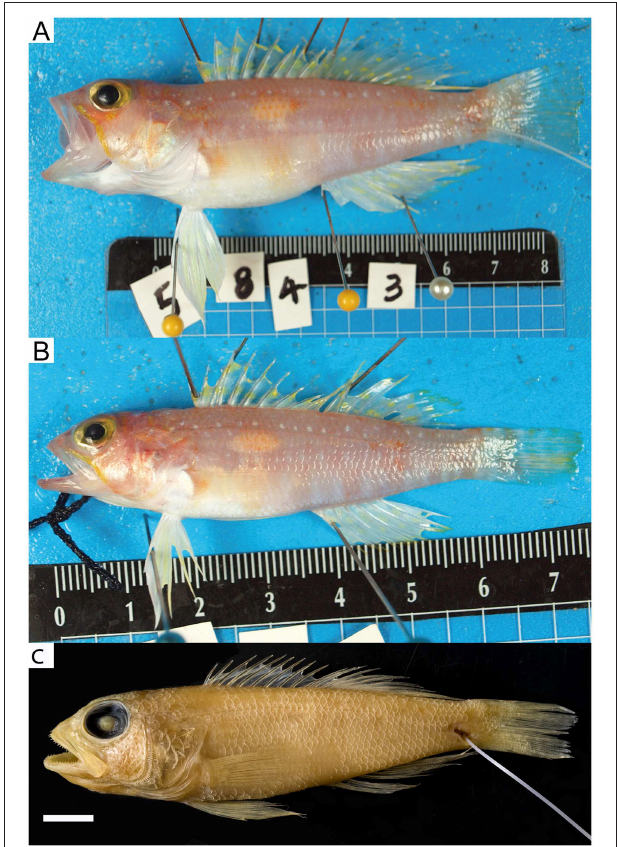
FIGURE 5 | Chelidoperca leucostigmata sp. nov. from north Macclesfield bank. (A) NTUM14721 (WJC5843, holotype), collected on 26 Jul 2015; standard length 85.0mm (photographed by WJC-Lab); (B) NTUM15634 (WJC5911, paratype), collected on 26 Jul 2015; standard length 57.6mm (photographed by WJC-Lab); (C) same specimen in (A) , showing preserved pigmentation (photographed by MYL). Bars = 10mm. pectoral-fin rays 15; pelvic-fin rays I, 5. Body fusiform, slightly elongated; snout round; caudal peduncle moderately